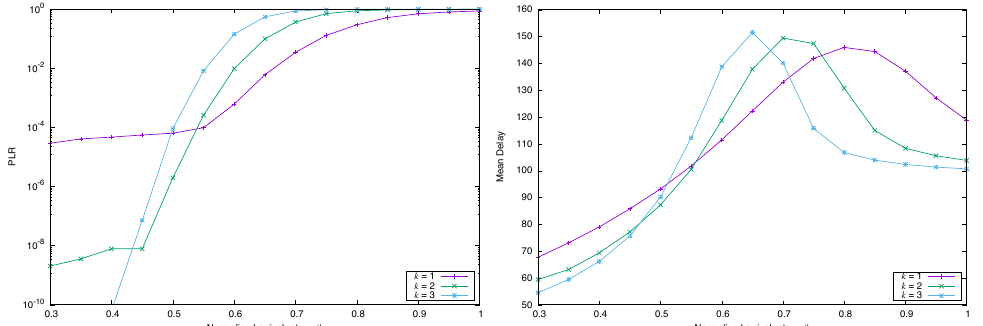
Figure 12. Simulated PLR ( left ) and Mean Delay ( right ) for FS-CSA versus λ a / k , with Λ ( x ) = 0.86 x 3 + 0.14 x 8 , n = 200 and k = { 1,2,3 } , and correlated arrivals with marginal Poisso- nian distribution.